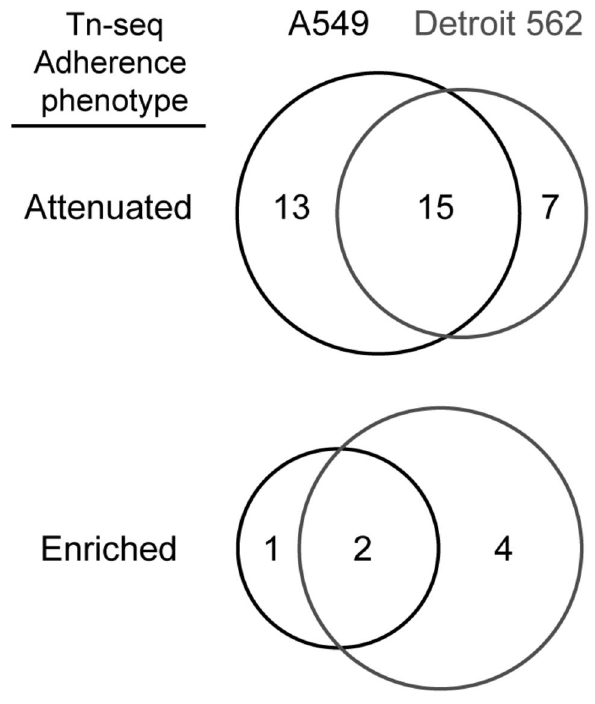
Figure 1. Genes affecting adherence of M. catarrhalis to respiratory tract epithelial cells. Overlap between genes identified by Tn-seq as important for adherence of